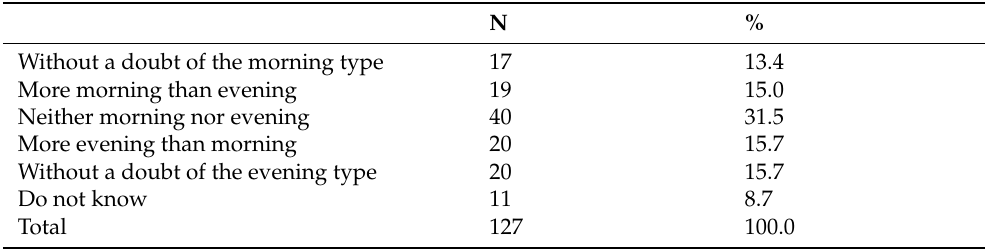
Table 3. Results of the use of the chronotype